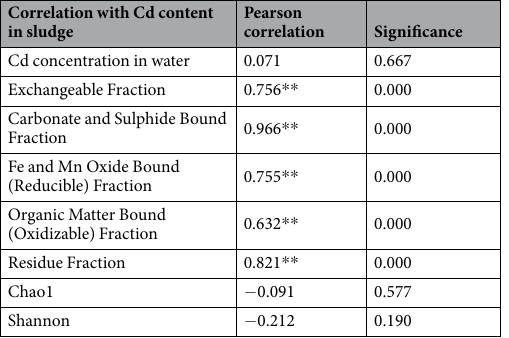
Table 3. Correlation between Cd content in sludge and Cd content in different phases, microbial richness (Chao1 index), and microbial diversity (Shannon index) in sludge samples. ** Represents significant at the level of